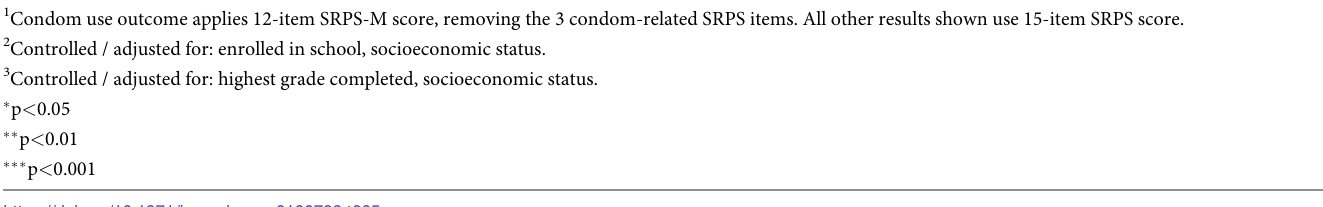
school or highest grade completed) was associated with condom use at last sex, whether the partner had other partners, and physical violence, for 18–20-year-olds. For the oldest group (21–24-year-olds), relationship power was associated with whether the partner had other part- ners, knowledge of partner’s HIV status, sexual violence, and physical violence. Schooling (i.e. enrollment in school or highest grade completed) was associated with condom use at last sex, knowledge of partner’s HIV status, and physical violence, for 21–24-year olds. Socio-economic status was not associated with any of the key outcomes, for any age band. To clarify the role of relationship power vis-à-vis the five outcomes, multiple logistic regression models were fit for each of the five partner violence and HIV risk outcomes on power in sexual relationships as measured by the SRPS (Table 5). Levels of relationship power predicted key outcomes for each age band of AGYW, when controlling for school- ing and socioeconomic status. Among 15–17-year-olds, AGYW with higher relationship power (i.e., higher mean score on the SRPS), reported decreased likelihood of sexual (aOR 0.13, 95% CI: 0.05–0.33, p < 0.001) and physical (aOR 0.18, 95% CI: 0.07, 0.47, p < 0.001) violence from intimate partners in the last year, compared to 15–17-year-olds with lower relationship power. This equates to seven times less likely to experience sexual partner violence, and more than five times less likely to experience physical partner violence. For 18–20-year-olds, those with higher relationship power reported decreased likelihood of sexual (aOR 0.15, 95% CI: 0.08, 0.30, p < 0.001) and physical (aOR 0.18, 95% CI: 0.09, 0.33, p < 0.001) violence from intimate partners in the last year, and increased likelihood of con- dom use at last sex (aOR 3.75, 95% CI: 1.60, 8.81, p < 0.01) compared to 18–20-year-olds with lower relationship power. This equates to six times less likely to experience sexual partner violence, over five times less likely to experience physical partner violence, and almost four times more likely to use a condom. For 21–24-year-olds, those with higher relationship power reported decreased likelihood of sexual (aOR 0.08, 95% CI: 0.04, 0.15, p < 0.001) and physical (aOR 0.17, 95% CI: 0.10, 0.29, p < 0.001) violence from intimate partners in the last year, and partner having other partners in the last year (aOR 0.10, 95% CI: 0.04, 0.22, p < 0.001), and increased likelihood of knowledge of partner’s HIV status (aOR 2.06, 95% CI: 1.10, 3.84, p < 0.05), compared to 21–24-year-olds with lower relation- ship power. This equates to more than 12 times less likely to experience sexual partner violence, and over 5 times less likely to experience physical partner violence, among the other findings.